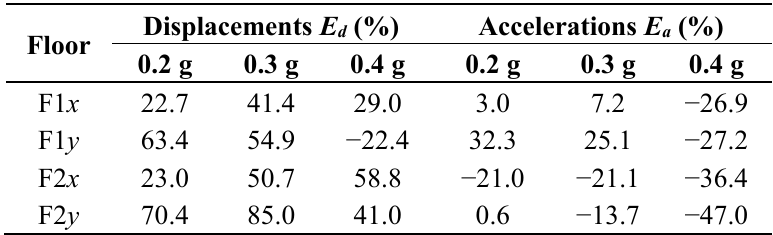
Table 6. Percentage errors (non-linear